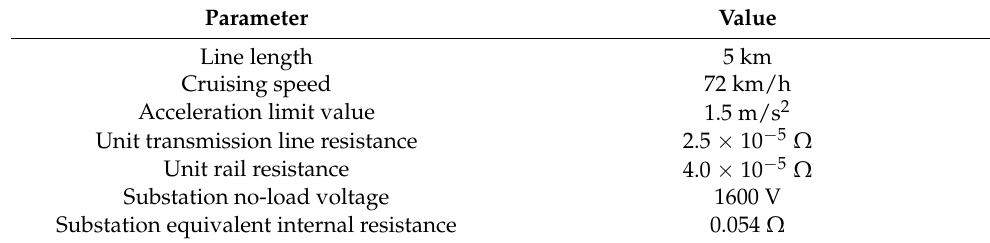
Table 3. Parameters of line and traction power grid.